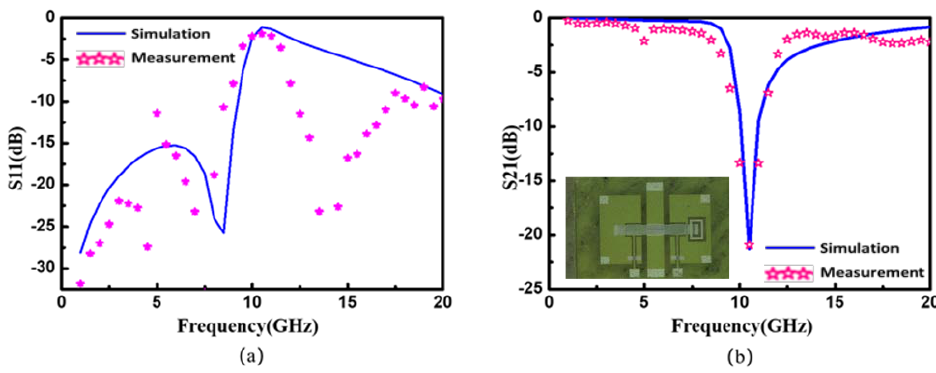
Figure 9. ( a ) S11 test results and simulation results; ( b ) S21 test results and simulation results. Table 4. Comparison of bandpass filters. Ref. Center